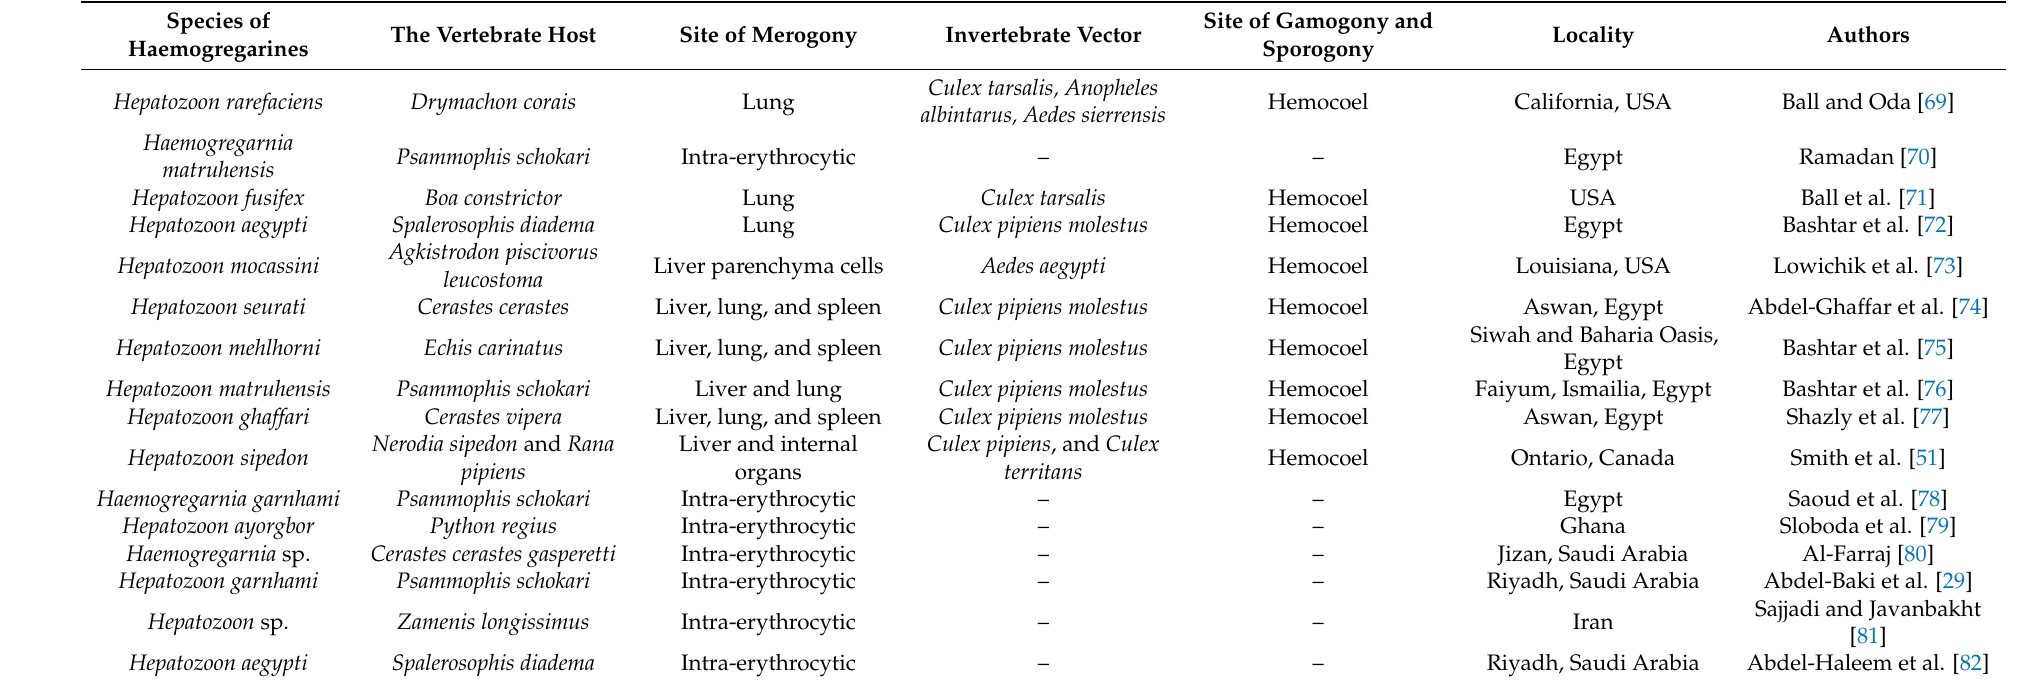
Table 5. Haemogregarines of